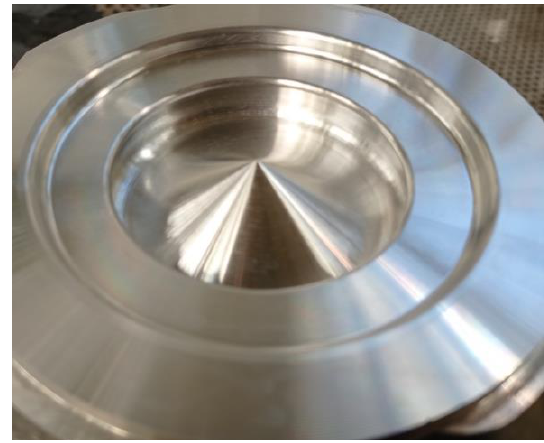
Fig. 7. Combustion chamber of an aluminum piston before the local DuralBowl remelting process